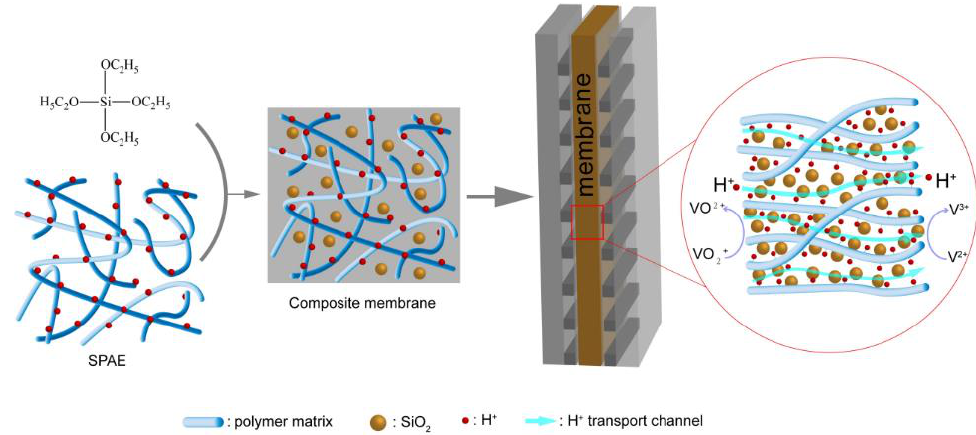
Figure 1. Schematic of VRFB based on the prepared SPAE/SiO 2 composite PEMs. The incorporation of SiO 2 into SPAE was confirmed by FT-IR spectra, as shown in Figure 2. The characteristic uptake peaks of SiO 2 appeared at 1087 cm − 1 (asymmetric stretching of Si - O - Si), 797 and 470 cm − 1 (symmetric stretching of Si - O), confirming the suc- cessful incorporation of SiO 2 into SPAE. It should be noted that the absorption peaks of SPAE are almost unchanged after the incorporation of SiO 2 , even though the - OH groups on SiO 2 may form hydrogen bonds with the - SO 3 H on SPAE. This may be because the hydrogen bonding within SPAE is much stronger than the hydrogen bonding between SiO 2 and SPAE.